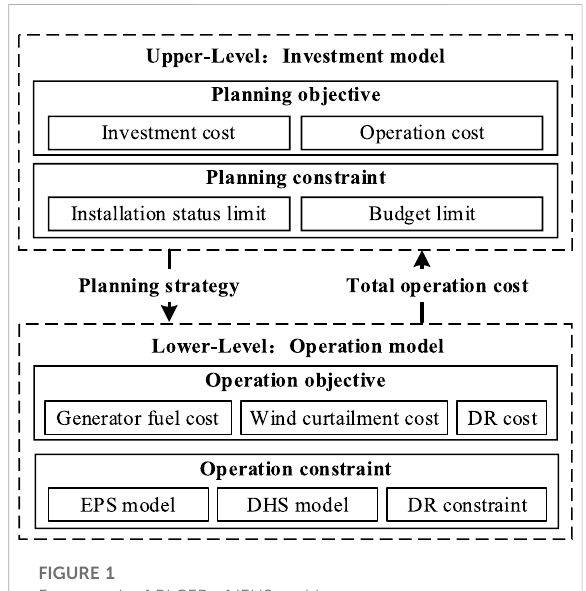
FIGURE 1 Framework of BLCEP of IEHS